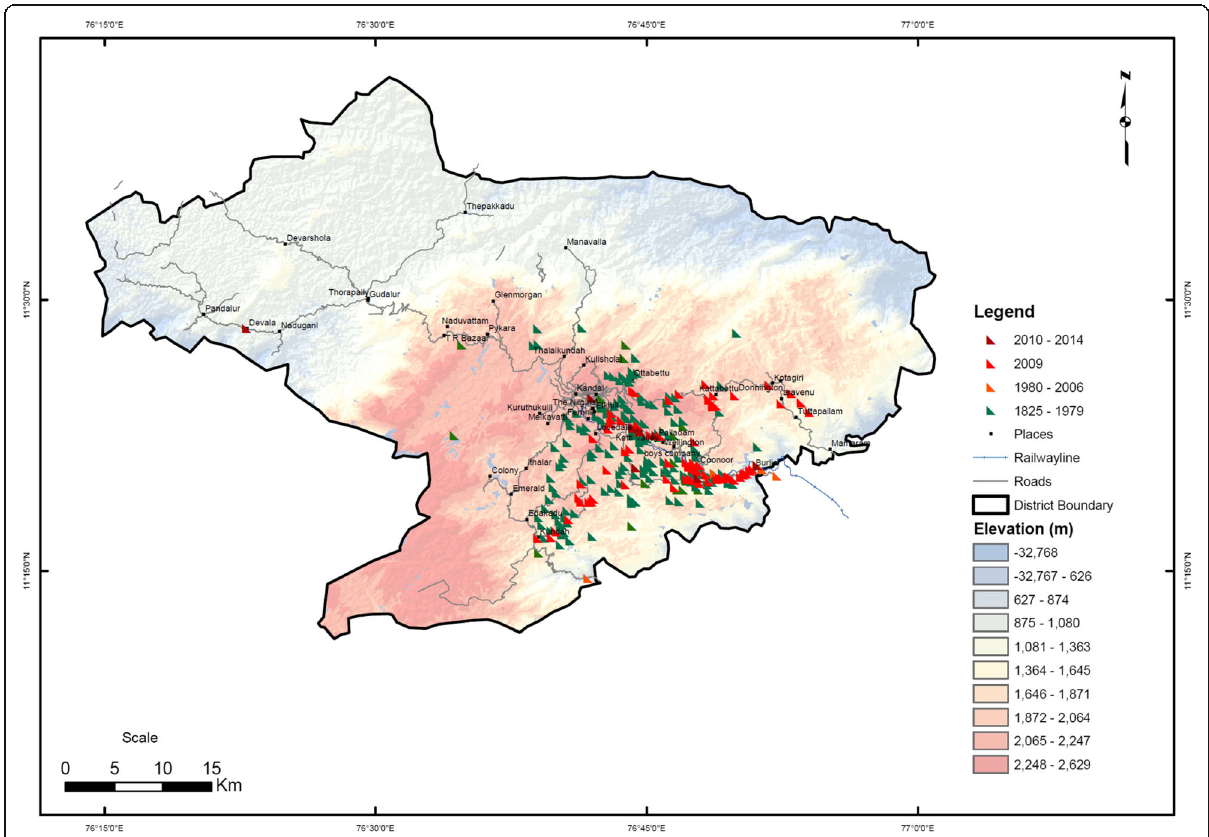
Fig. 9 Updated landslide inventory map of the Nilgiris